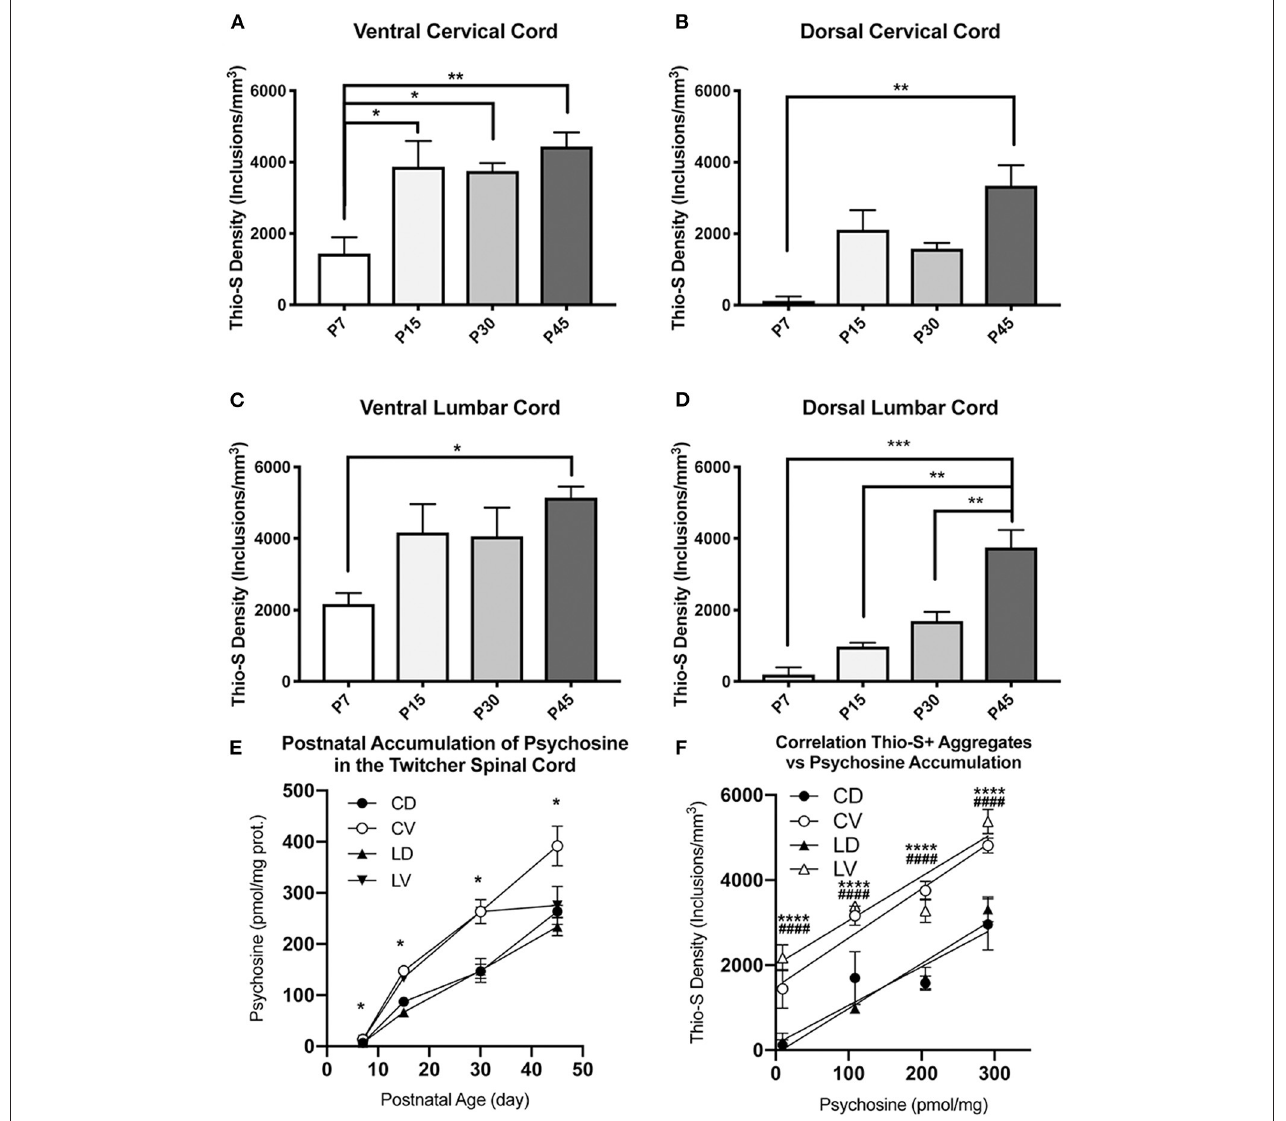
FIGURE 3 | Quantification and comparison of thioflavin-S accumulations across life-span. Stereological analysis of thioflavin-S accumulation density (inclusions/mm 3 ) was performed. The ventral cervical and lumbar cords revealed large early accumulations at P7 and P15 with relatively slight additional accumulation over the final two time points (A,C) . The dorsal spinal cord (B,D) showed a more protracted accumulation across life span. Psychopsine levels were measured in the cervical ventral (CV), cervical dorsal (CD), lumbar ventral (LV), and lumbar dorsal (LD) cord regions. This was compared across post-natal development (E) and in correlation to thio-s accumulation (F) . (A–D) Significance between means analyzed by ANOVA and Tukey’s post-hoc analysis with (*) indicating p < 0.05, (**) p < 0.01, and (***) p < 0.001, n = 3–4 animals. (E,F) Significance between means analyzed by ANOVA and Tukey’s post-hoc analysis with (*) indicating p < 0.05 and (****) p < 0.0001 in comparison between CV and CD; (####) p < 0.0001 in comparison between LV and LD, n = 2–3 animals. Results are presented as mean ± error of the